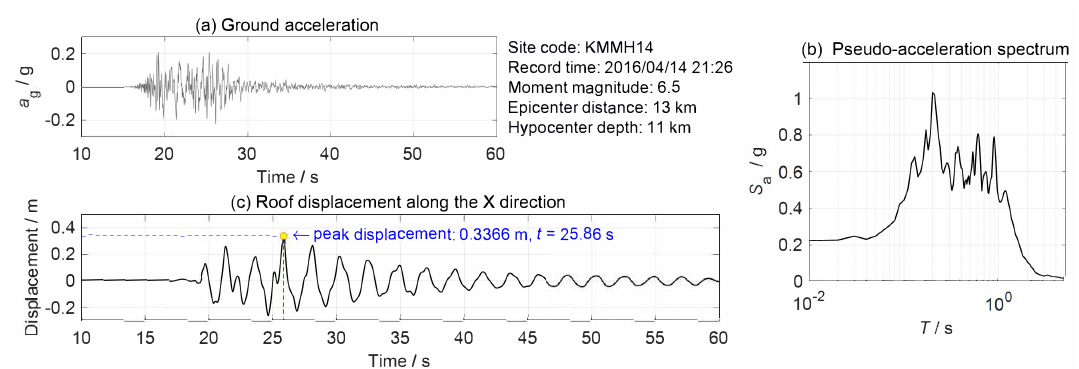
Figure 6. Earthquake excitation and displacement response of the building: ( a ) time history of the ground acceleration, ( b ) pseudo-acceleration spectrum, and ( c ) roof